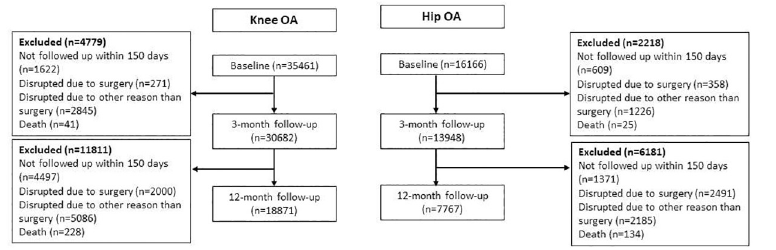
Fig 1. Flow-chart of the study